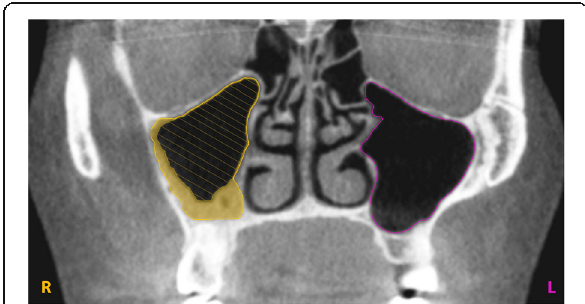
Fig. 2 View from the coronal plane. The marked curves define the osseus and mucous boundaries of the maxillary sinuses. The hatched surface illustrates the measured remaining pneumatized